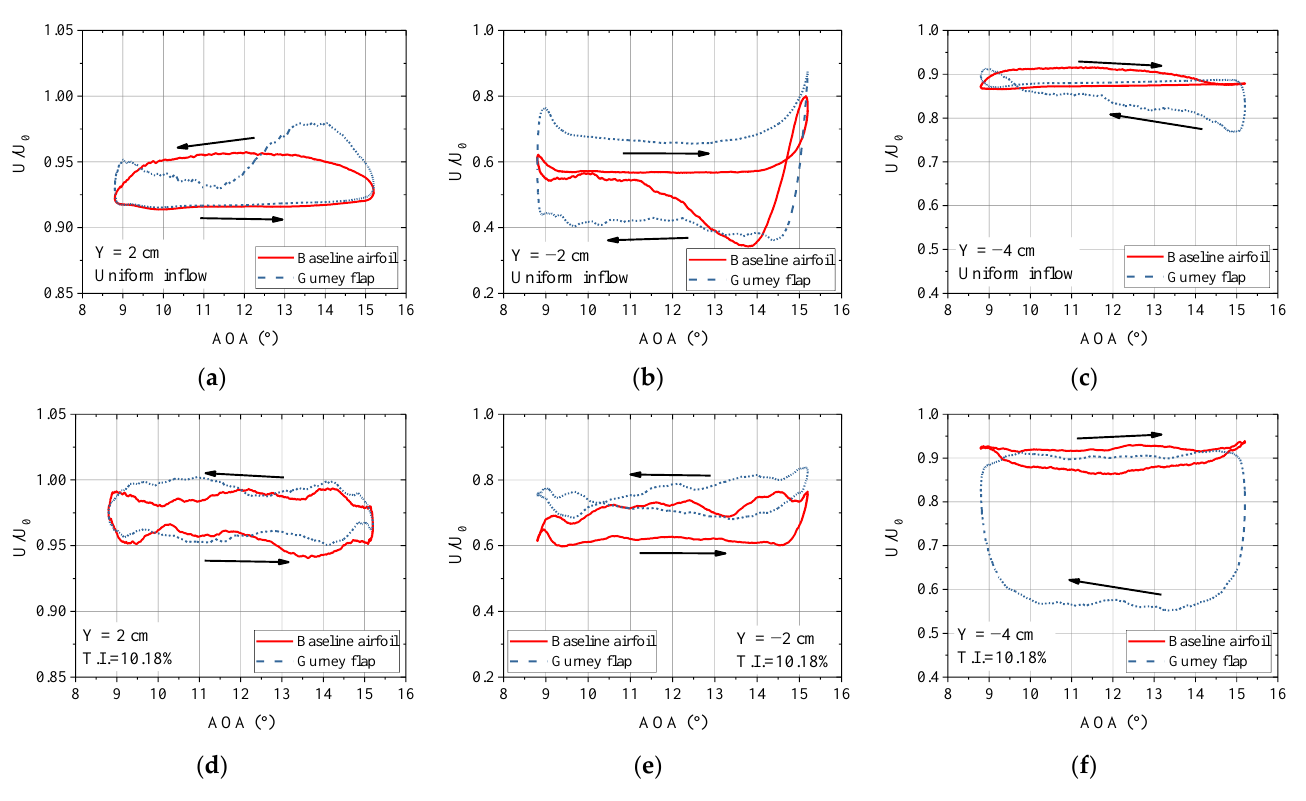
Figure 12. Comparison of wake velocity hysteresis loops. ( a ) uniform inflow, Y = 2 cm; ( b ) uniform inflow, Y = − 2 cm; ( c ) uniform inflow, Y = − 4 cm; ( d ) T.I. = 10.18%, Y = 2 cm; ( e ) T.I. = 10.18%, Y = − 2 cm; ( f ) T.I. = 10.18%, Y = − 4 cm.